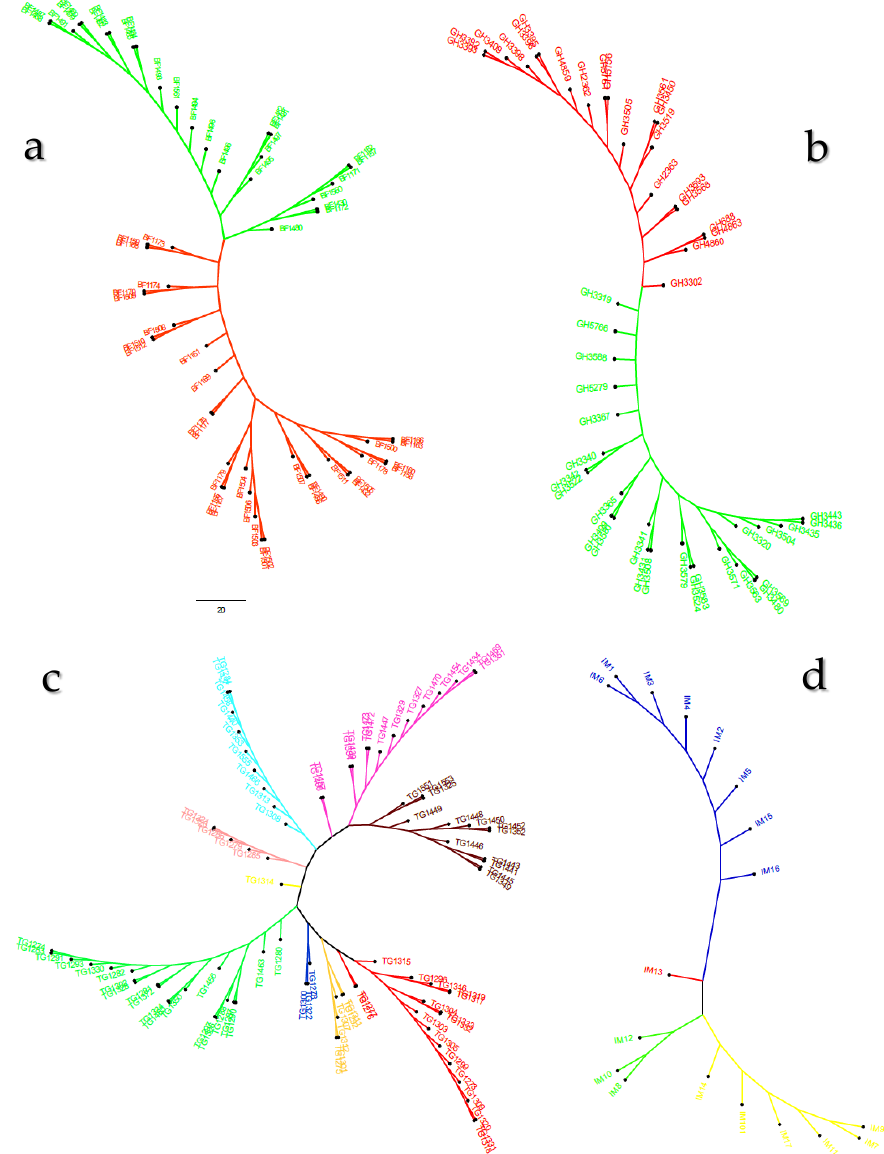
Figure 6. Unrooted neighbor joining tree depicting genetic relationships among Burkinabe ( a ), Ghanaian ( b ), and Togolese ( c ) landrace gene pools, and a reference population ( d ). Colors of each tree represent genetic